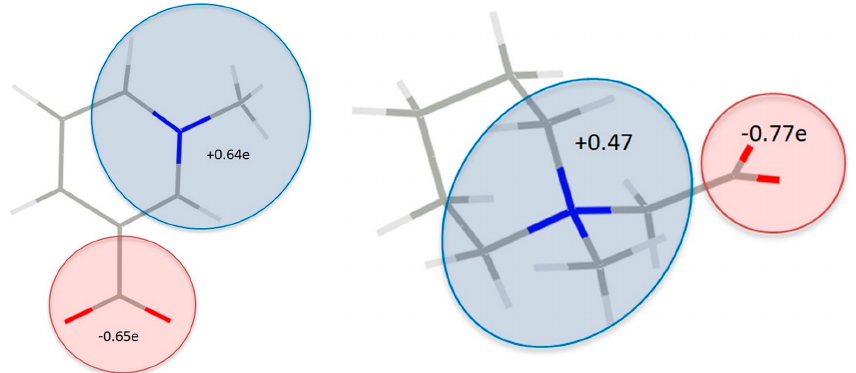
Figure 8. Combined atomic charges for selected groups in 1 ( left ) and 2 ( right ).